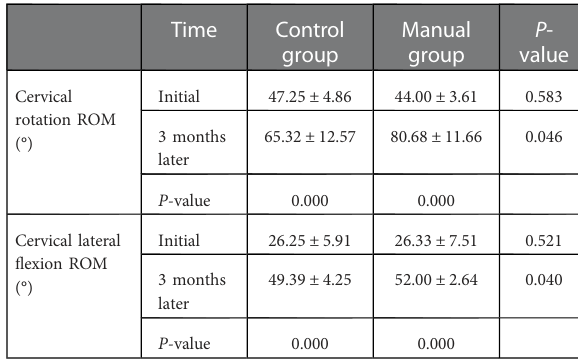
TABLE 2 Changes in the cervical range of